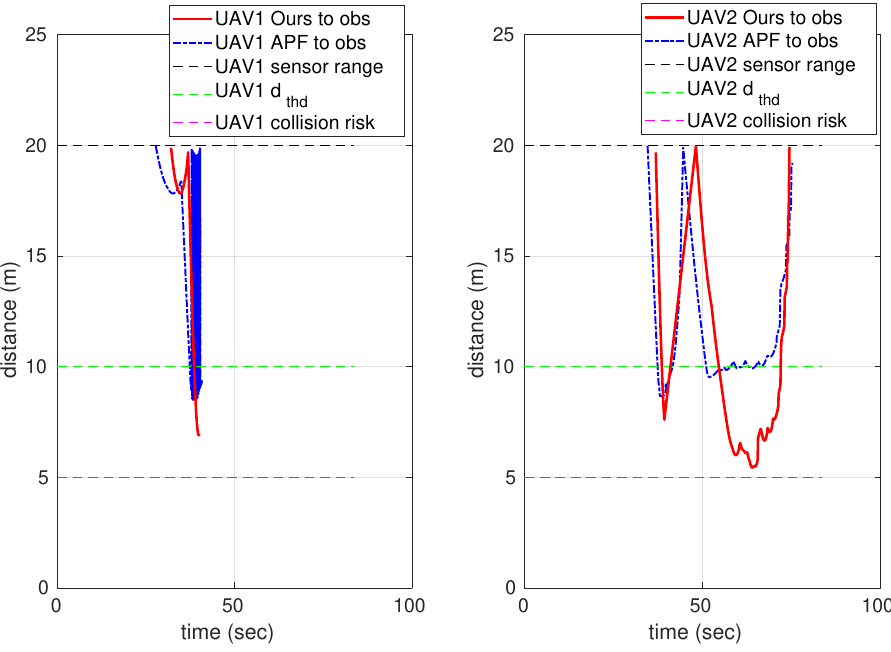
Figure 20. Relative distance to the nearest obstacle in the complex environment case.